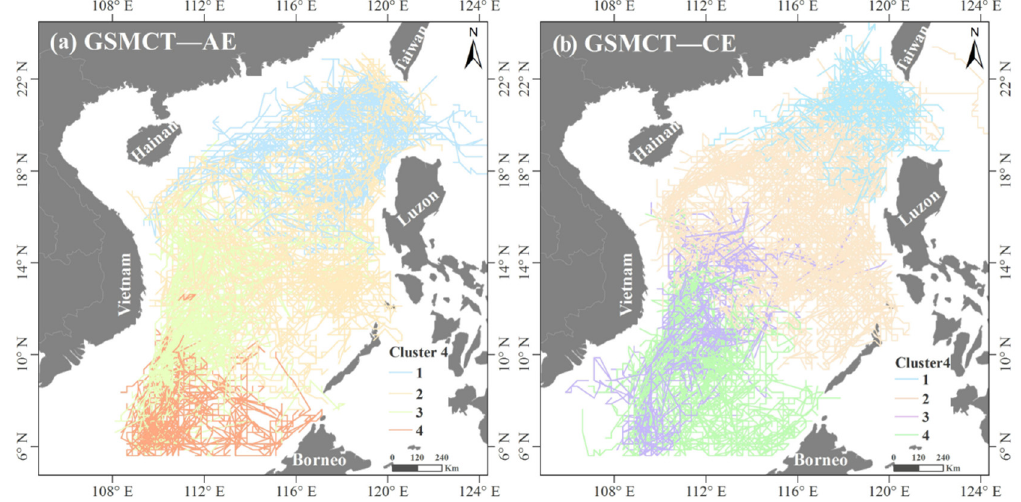
Figure 5. Clustering results of complex trajectories of anticyclonic eddies (AE) (a) and cyclonic eddies (CE) (b) in the South China Sea (SCS) using the global similarity measuring algorithm for complex trajectories (GSMCT) proposed by Wang et al. [31].